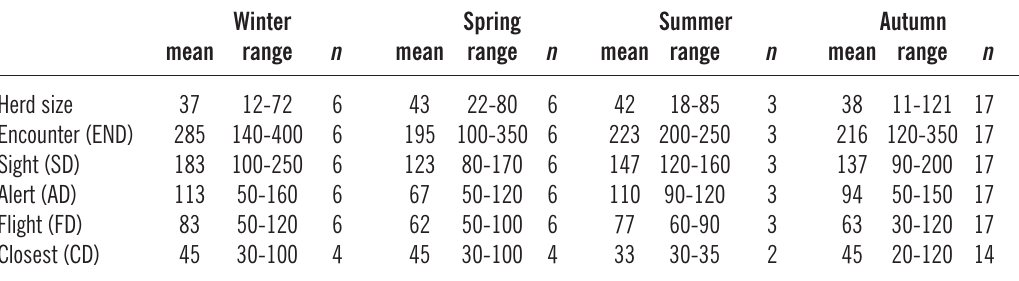
Table 6. Observed response distances of semi-domestic reindeer in Finland during different seasons, when provoked by an observer on foot/snowshoes in 2010-12 (data pooled across